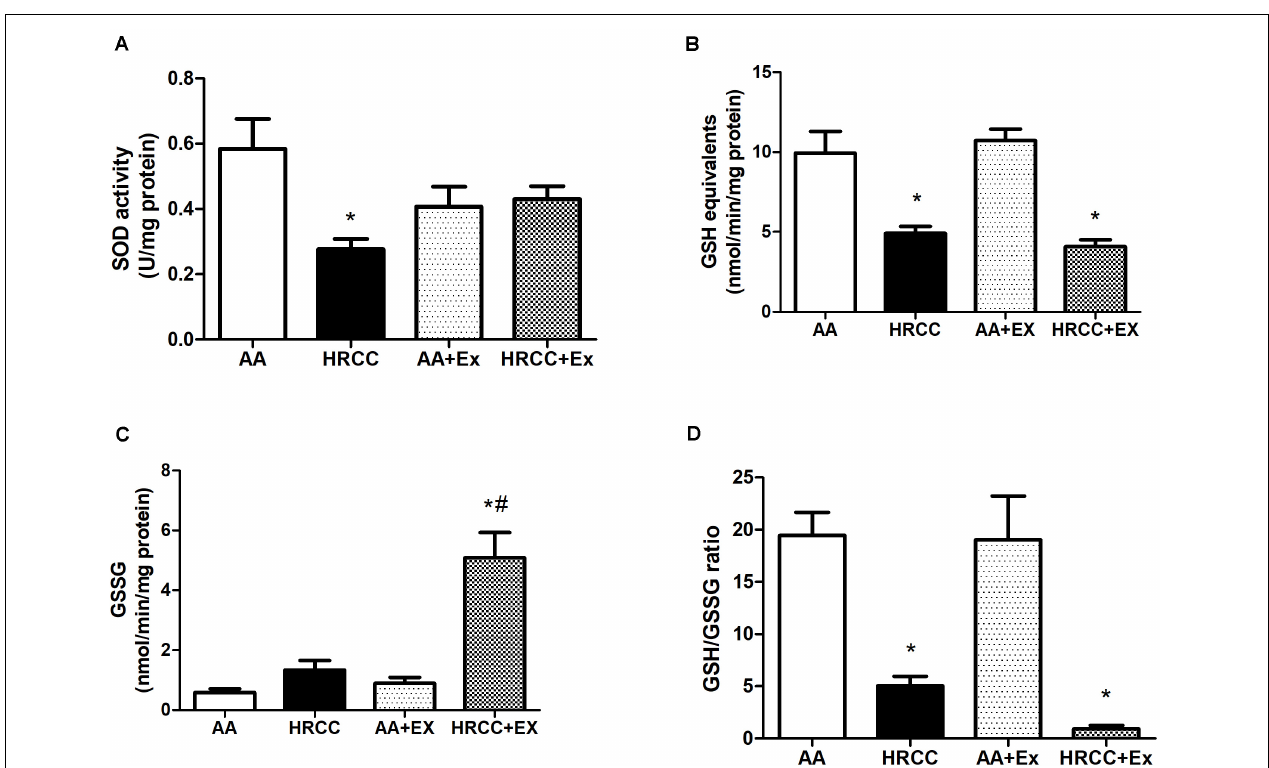
FIGURE 5 | Effect of combined exercise on antioxidants in quadriceps of mice exposed to hand-rolled cornhusk cigarette (HRCC) smoke. Superoxide dismutase activity (SOD) (A) , Total GSH activity (B) , GSSG level (C) , and glutathione (GSH)/oxidized glutathione (GSSG) ratio (D) are shown as the mean and standard error of the mean and were analyzed statistically using two-way ANOVA, followed by the Newman–Keuls test. The groups were considered different when p ≤ 0.05* (difference in relation to the ambient air, # difference in relation to